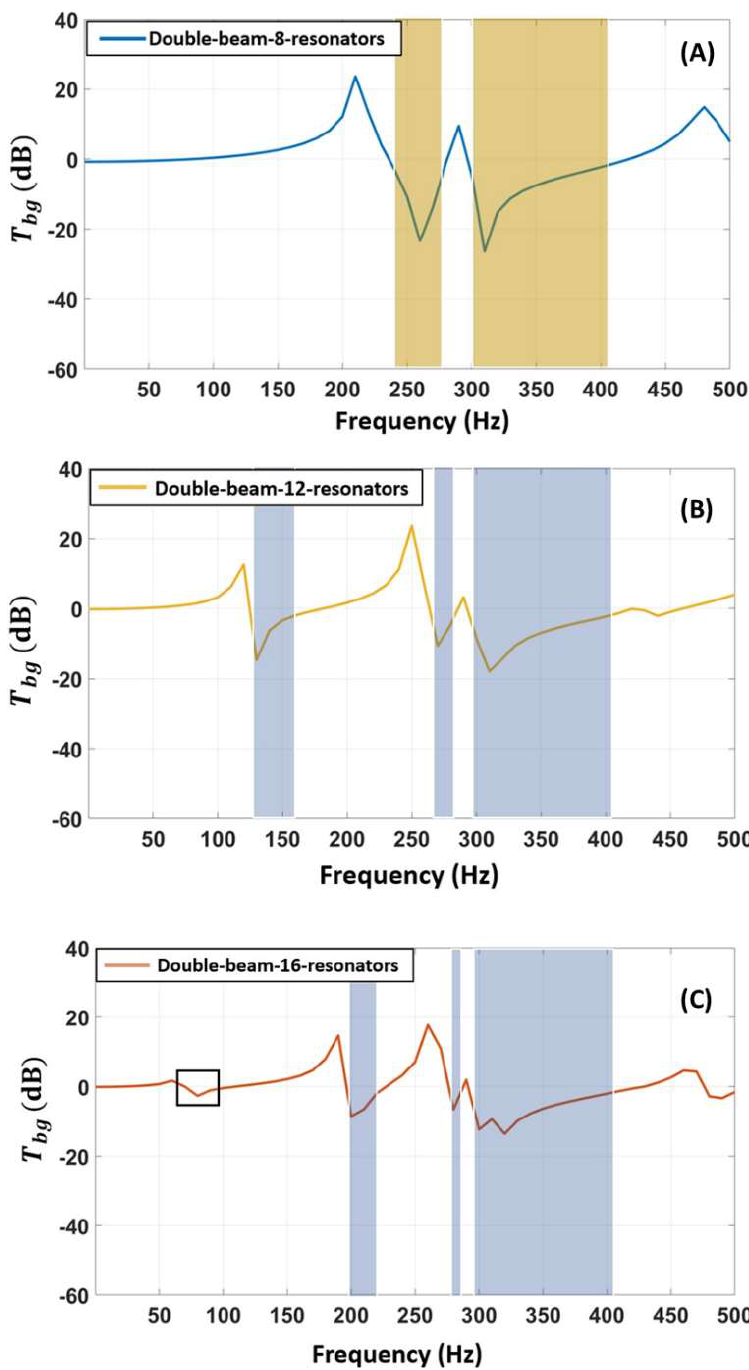
Figure 8. Transmissibility of a double-beam metamaterial structure when the number of local resonators per horizontal beam is increased: ( A ) A double-beam metamaterial structure with 8 local resonators; ( B ) a double-beam metamaterial structure with 12 local resonators; ( C ) a double-beam metamaterial structure with 16 local resonators.